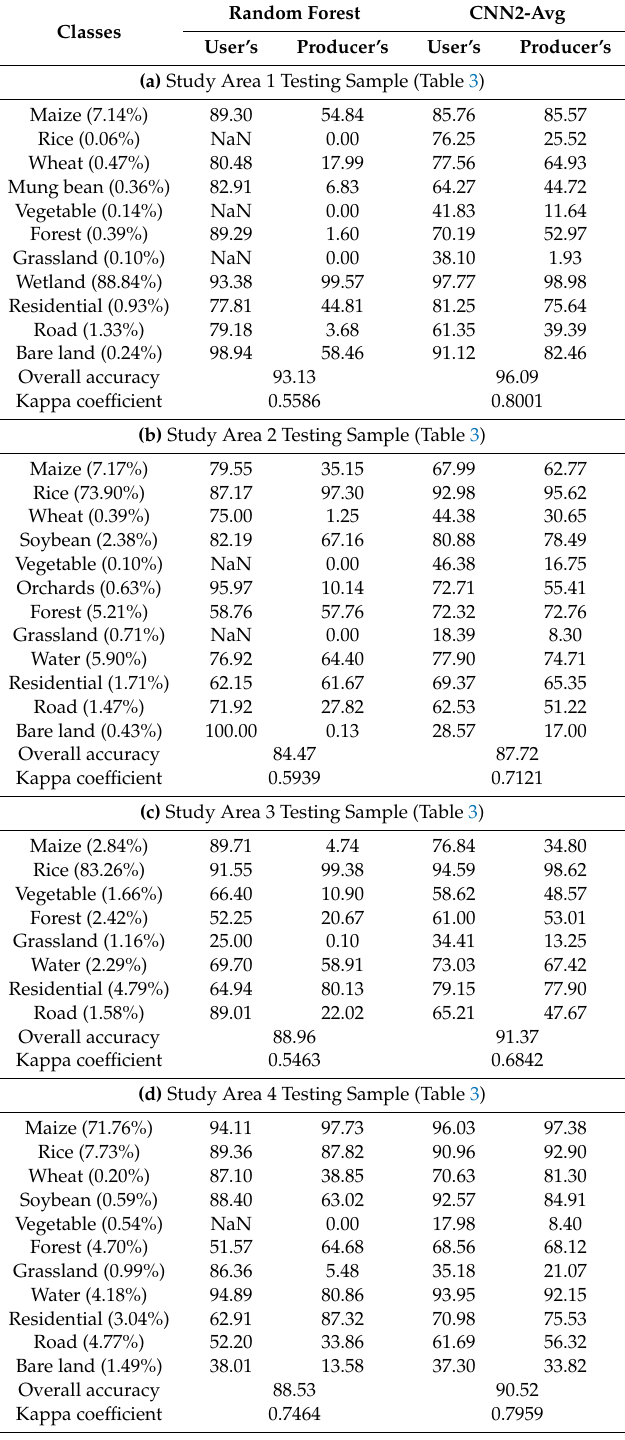
Table 5. Study areas 1–4 testing samples (Table 3) accuracies of the random forest and the best CNN model (i.e., the CNN with average pooling and ~290,000 learnable parameters). The training sample percent to the total training samples (the value is same for the testing sample in Table 3) is shown in the bracket after class